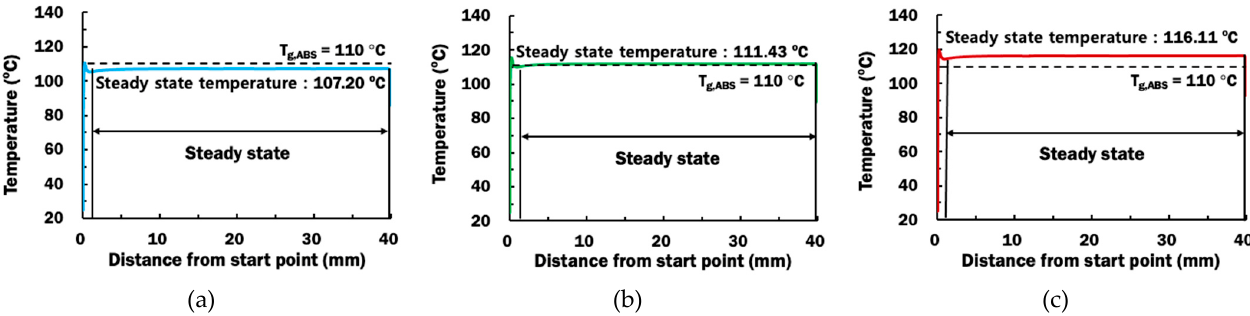
Figure 14. Estimated peak temperatures along the length of bead from start point for different printing temperatures: ( a ) T p = 230 °C; ( b ) T p = 240 °C; ( c ) T p = 250 °C.